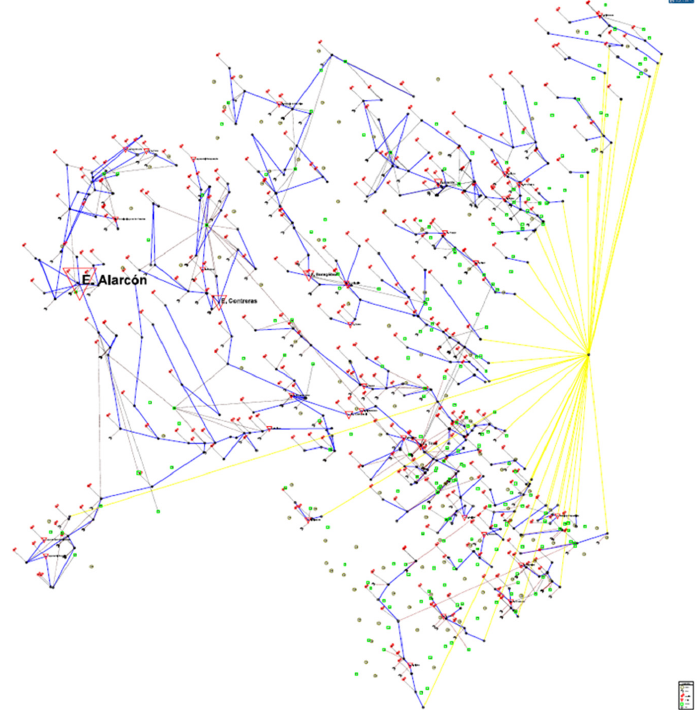
Figure A2. Jucar River Basin District Exploitation System in SIMGES module of AQUATOOL Decision Support System Shell